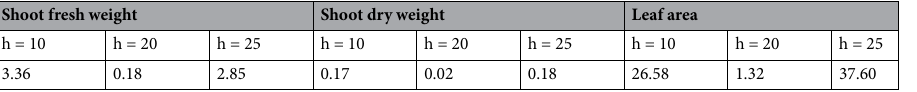
Table 2. Mean absolute error values of the used BNN models with different number of hidden layers h for modelling the daily growth rate of fresh and dry weight, and the leaf area daily growth.